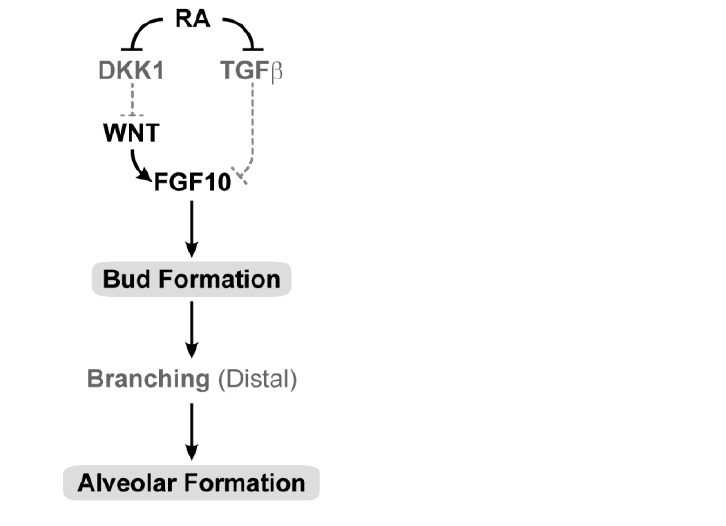
Figure 6. Schematic showing the proposed sites of RA action in lung development. In the developing embryo, RA is needed for primary bud formation (grey oval), but signaling is down-regulated during the time that lung differentiation occurs. A later role for RA in alveolar formation (grey oval) is also proposed. During induction of the lung buds, RA regulates mesodermal Fgf10 levels by negatively regulating Tgfβ and enabling induction of the Wnt pathway by repression of the Dickkopf homolog 1 ( Dkk1 ) known to antagonize Wnt ligand-receptor binding. RA may also influence the response of the foregut endoderm (origin of lung progenitors) to Fgf10 . (Adapted from